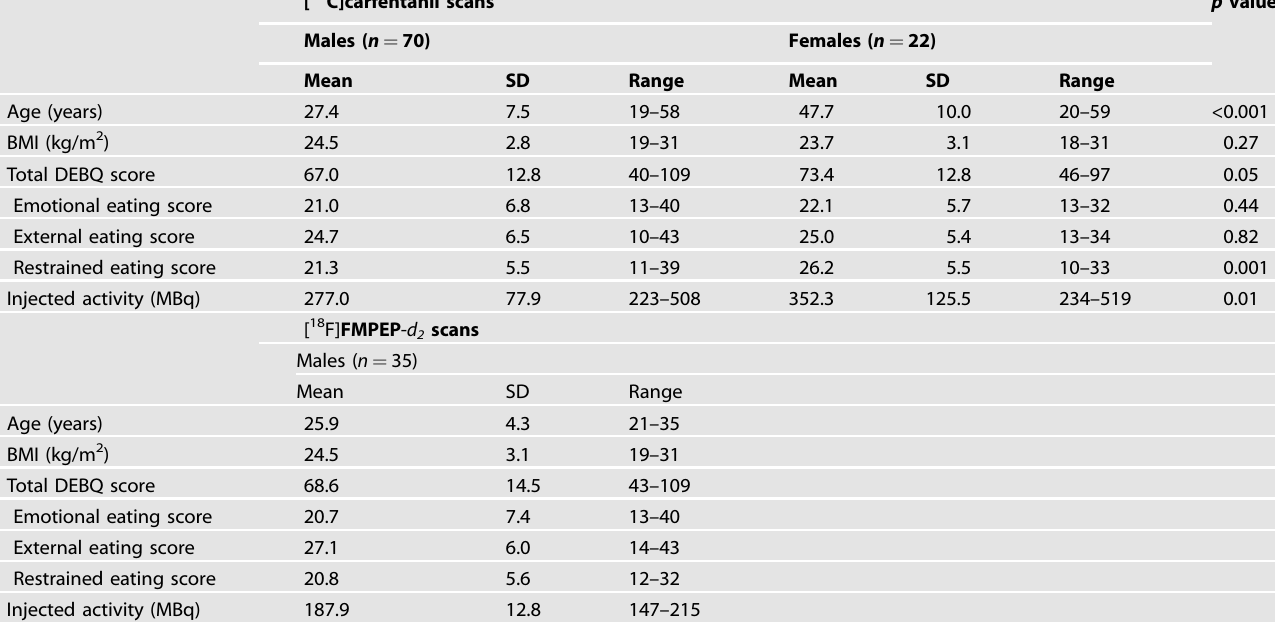
Table 1. Characteristics of the studied